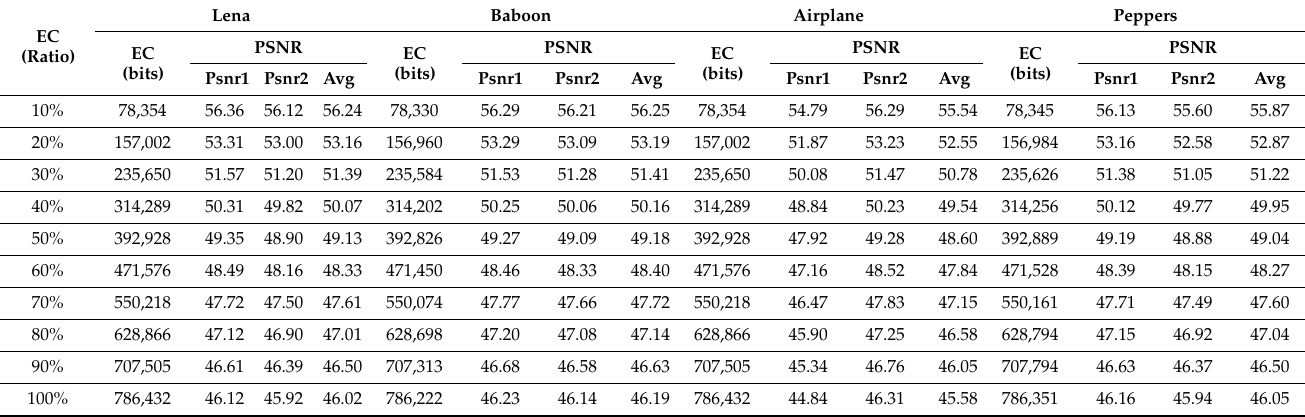
Table 4. Comparison of embedding capacity and PSNR value of different stego images for n = 2.